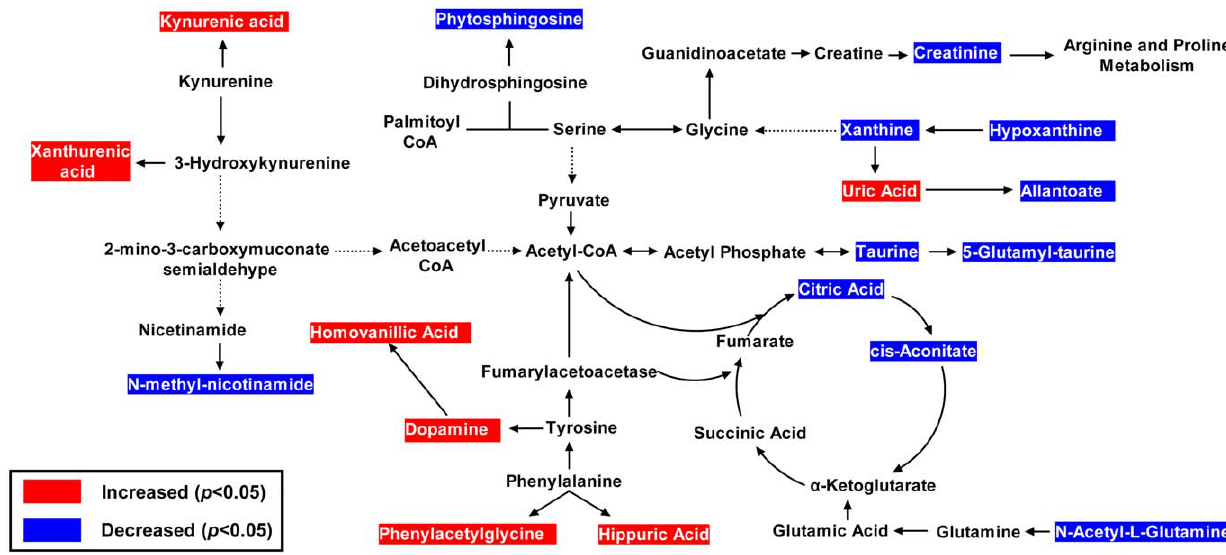
Figure 7. The integrative plot of the metabolites and the relevant pathways changing for thyroidectomy-induced hypothyroidism in circulation system. Metabolites with red dashed area present significant increase in Hypo group compared to Sham group. Metabolites with blue dashed area present significant decrease in Hypo group compared to Sham group.